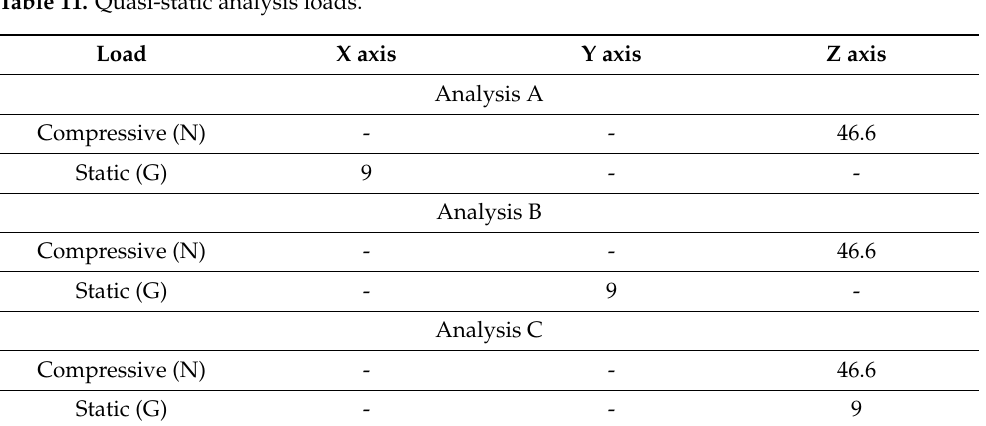
Table 11. Quasi-static analysis loads.